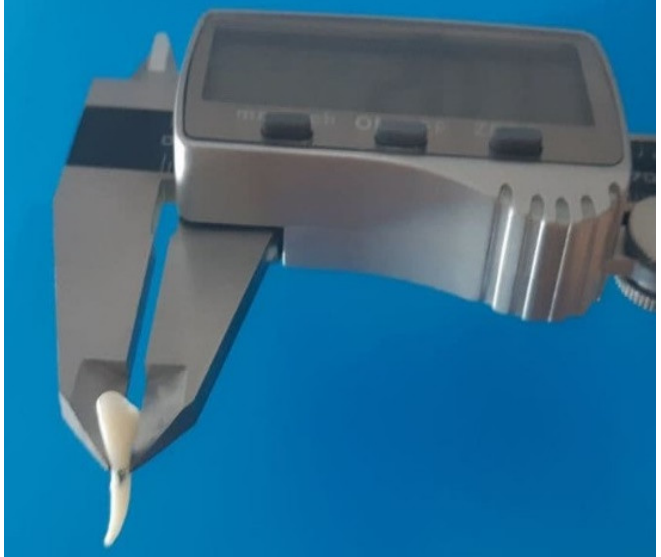
Figure 2. Digital caliber measurements of the mesio-distal and buccal-lingual diameters (hundredths millimeter precision). In the first case the locating branches of the caliber were placed on the midpoint of the mesial face and midpoint of the distal face of the tooth, likewise it was carried out for the measurement of the buccal-lingual diameter.